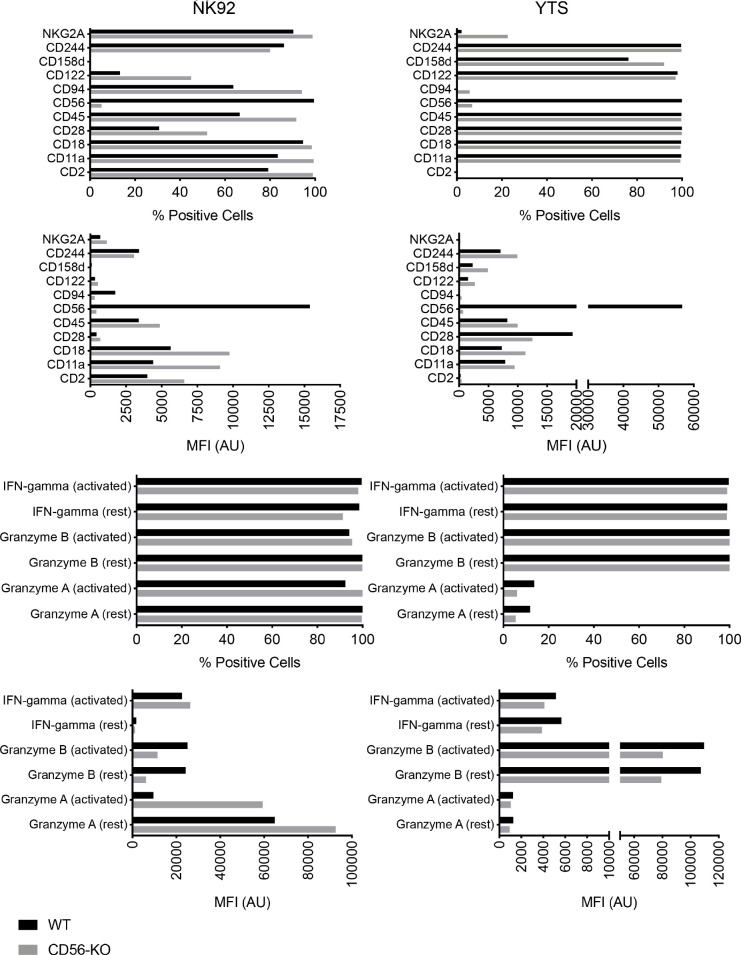
Phenotyping of NK cell lines by flow cytometry.NK92 and YTS WT and CD56-KO cells were analyzed for expression of cell surface receptors and intracellular effector molecules using five panels as described in Materials and methods. Effector functions were evaluated in the presence (activated) or absence (rest) of activation by PMA and ionomycin. Mean fluorescence intensity was measured and % positive cells based on fluorescence minus one gating was also calculated. Shown is one representative of 3 independent experiments.